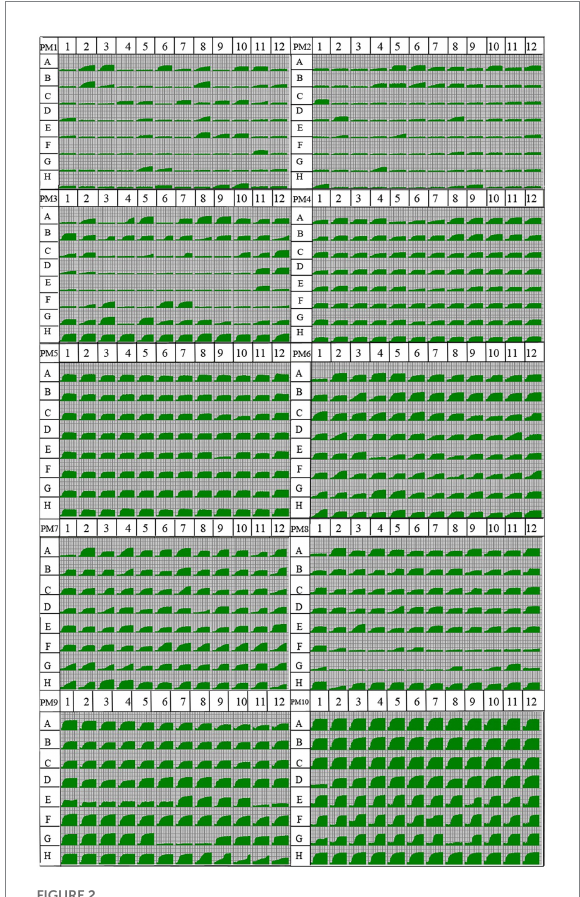
FIGURE 2 Data for biology phenotype microarray PM 1–8 plates of the pathogen Rhizopus oryzae. Utilization of the isolate Y5 of R. oryzae from tobacco was indicated by green areas in the growth curve for each substrate, the larger the green area, the higher the utilization. A kinetic response curve which parallels microbial growth can be generated for each well, allowing growth to be compared between samples through multiple parameters such as lag, slope, and area under the